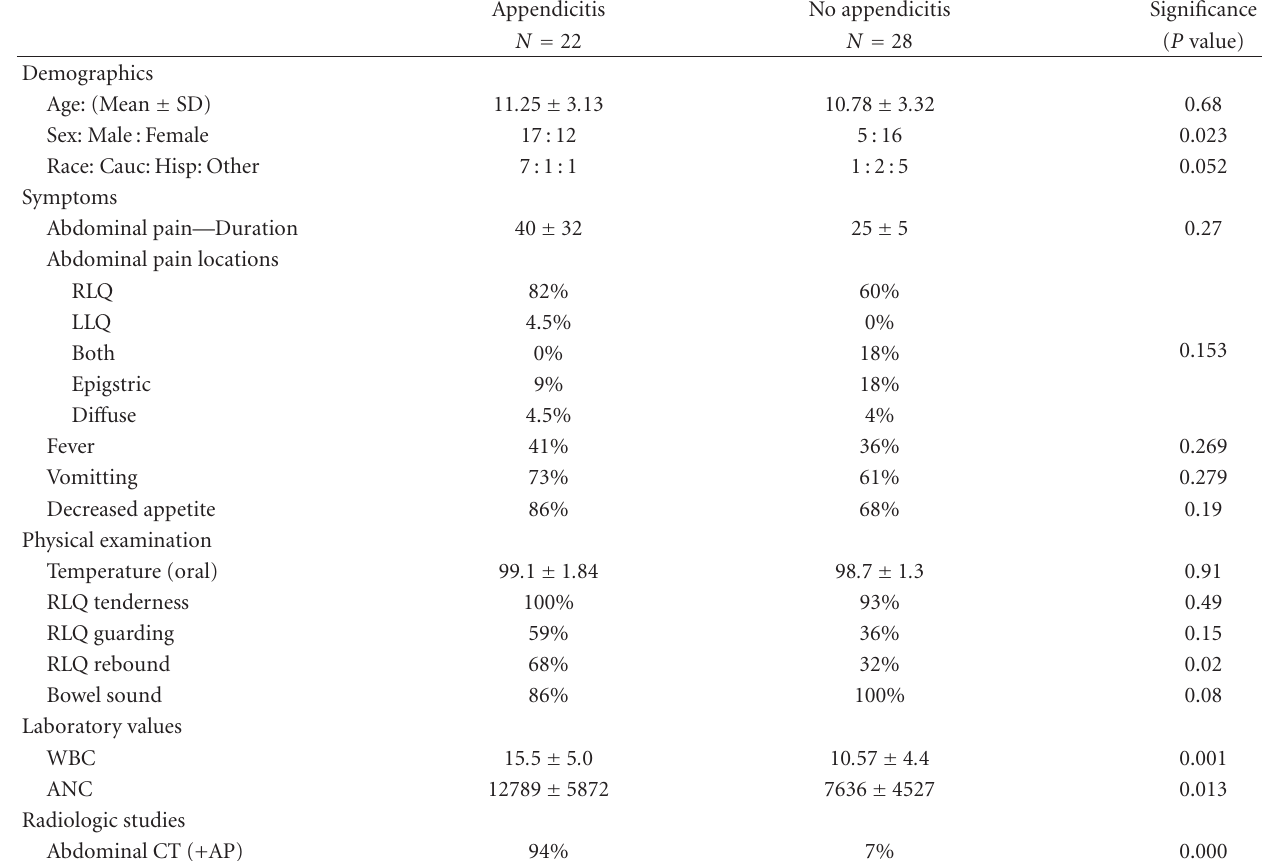
Table 1: Demographics and clinical